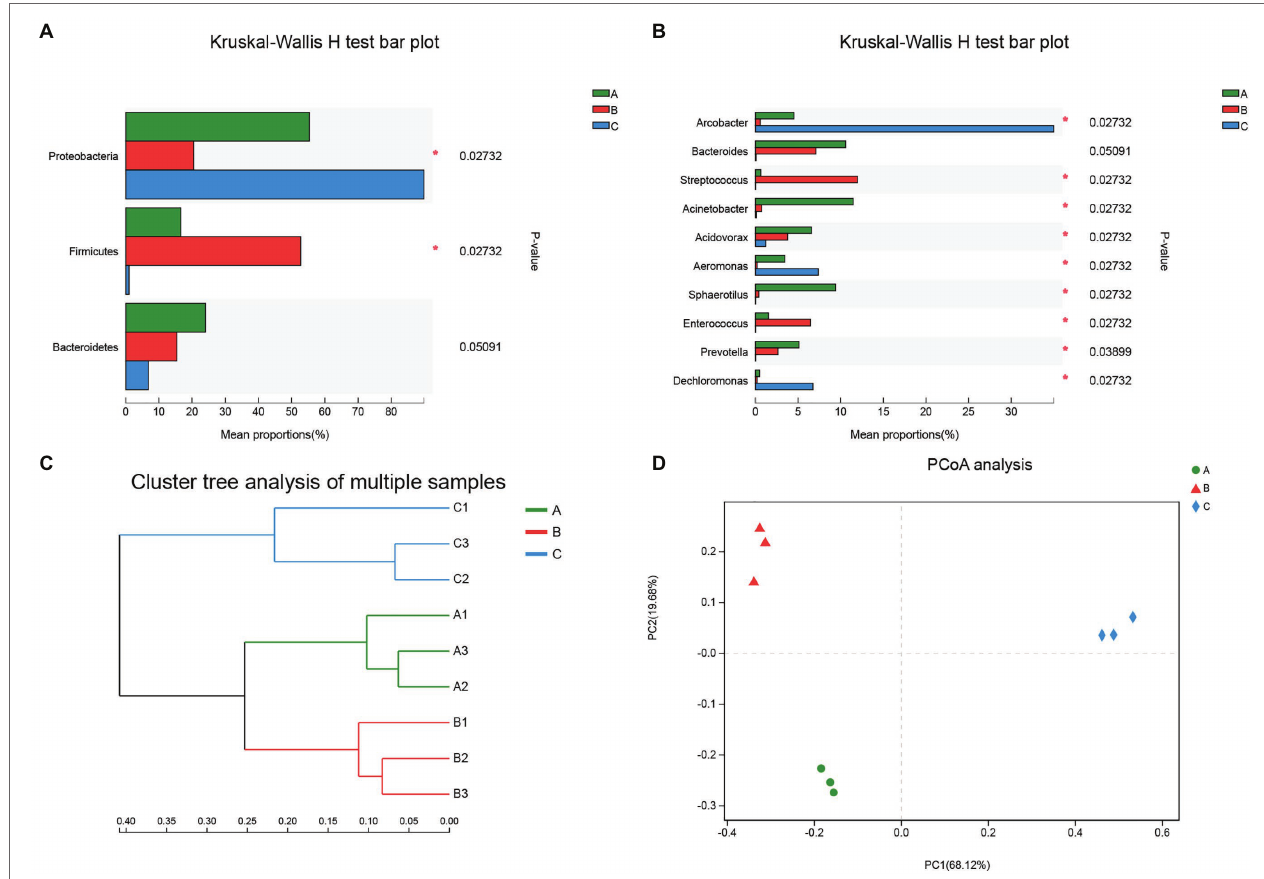
FIGURE 2 | Statistical comparison of the relative abundance. (A,B) Microbiota composition difference in Phylum and Genus level; (C,D) Relationship of microbiota community between three groups analyzed on cluster tree and principal coordinate analysis (PCoA). Green (bar, line, or circle), A group, samples from Affiliated Hospital of Southwest Medical University; Red (bar, line, or triangle), B group, samples from Affiliated TCM Hospital of Southwest Medical University; Blur (bar, line, or diamond), C group, samples from Hospital of Stomatology Southwest Medical University. Differences were considered statistically significant at * p < 0.05